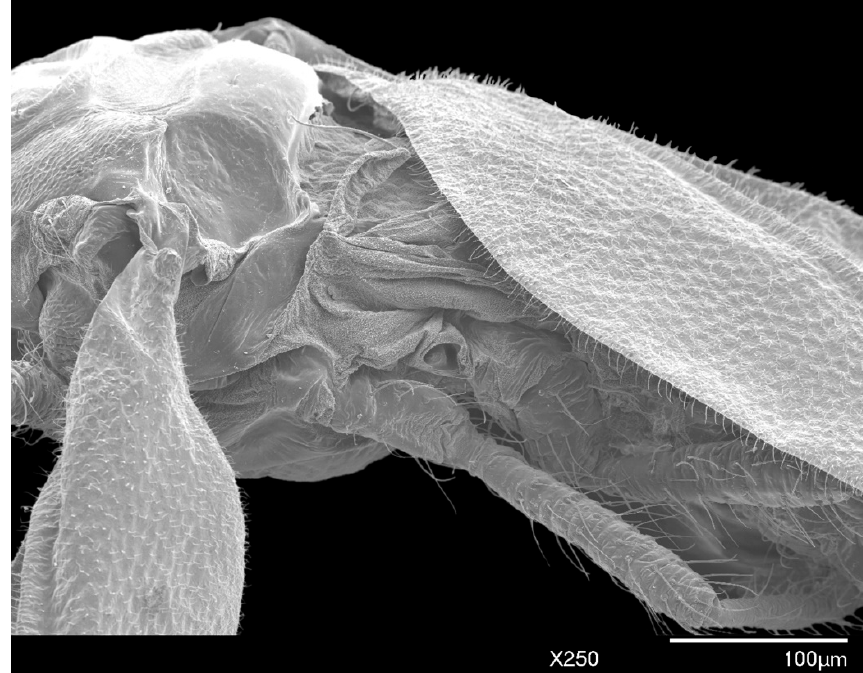
Figure 11. SEM lateral view of the peritreme of the metathoracic spiracle metaepisternum of male A. galliformis also showing the microtrichia, costal complex of the wing, alar, and additional sclerite. Metathorax: Indistinct and weakly sclerotized. The metasternal plate is not visible. There are 11–19 (mean 16) ventral setae. Dorsal setae are absent.